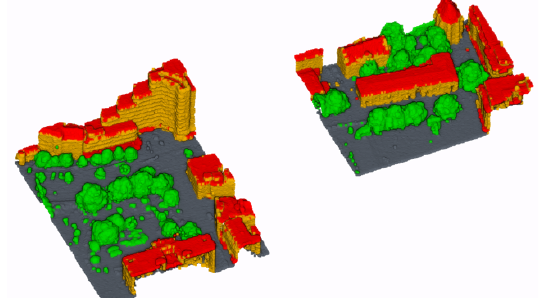
Figure 5. Dortmund point cloud training (left) and evaluation (right) sets. Points are manually labelled in GLO (blue), roof (green), façade (yellow) and vegetation (red).